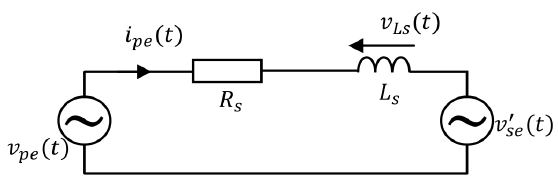
Figure 2. Primary referred